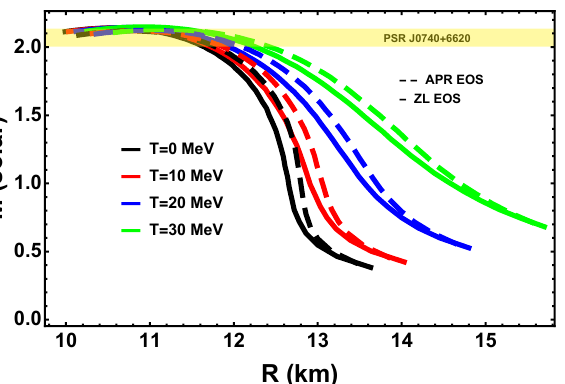
Figure 3. The effects of temperature on a neutron star’s structure. As the temperature increases, degeneracy is lifted. This means that the stars will essentially “puff” up without gaining more